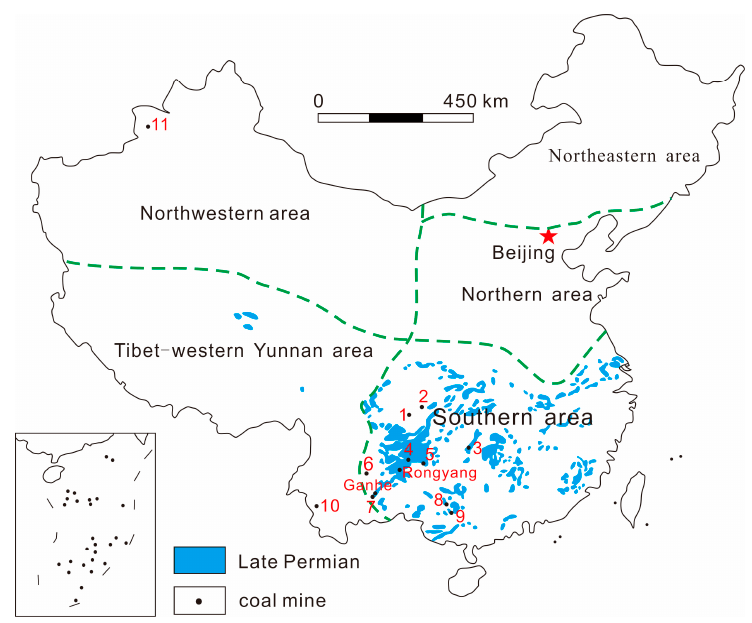
Figure 1. The distribution of high-U coal mines within China: 1, Moxinpo; 2, Guxu; 3, Chenxi; 4, Zhijin; 5, Guiding; 6, Longquan; 7, Yanshan; 8, Yishan; 9, Heshan; 10, Lincang; 11, Yili (after Dai et al. [30]).